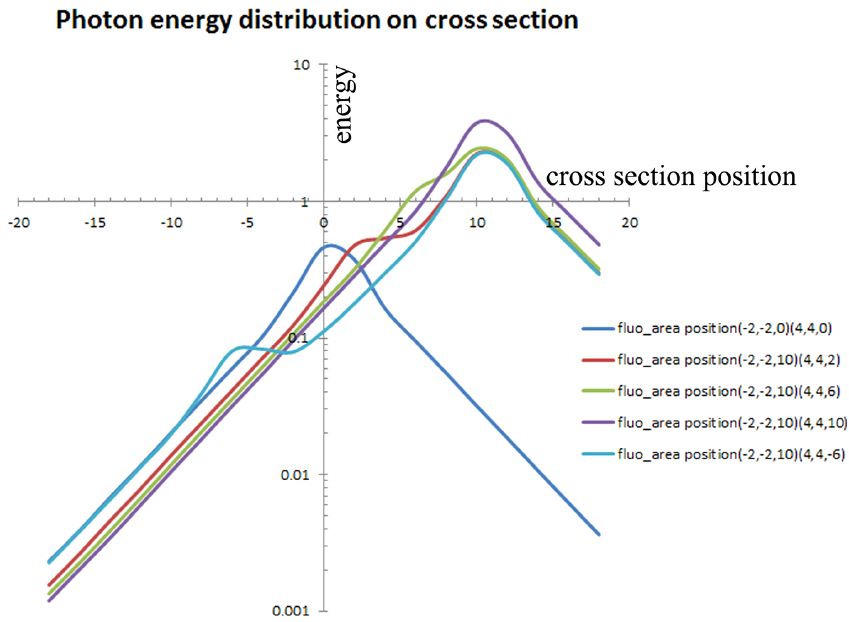
Fig. 7. Photon energy distribution on cross